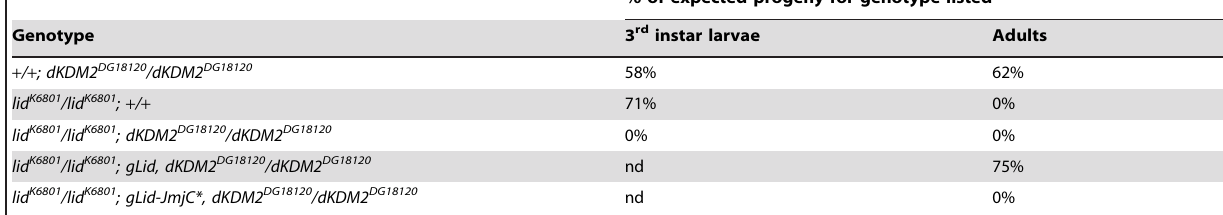
% of expected progeny for genotype